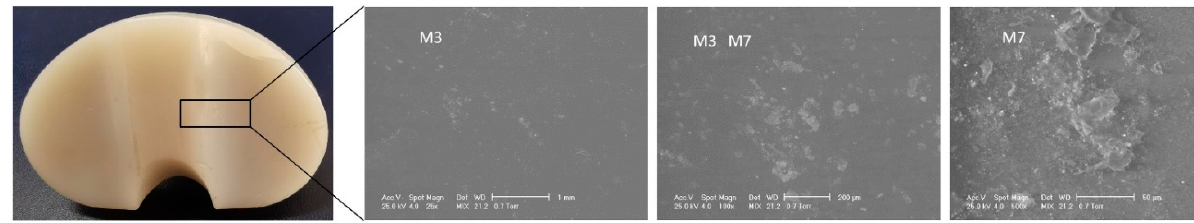
Figure 8. SEM images obtained for IT1 sample.